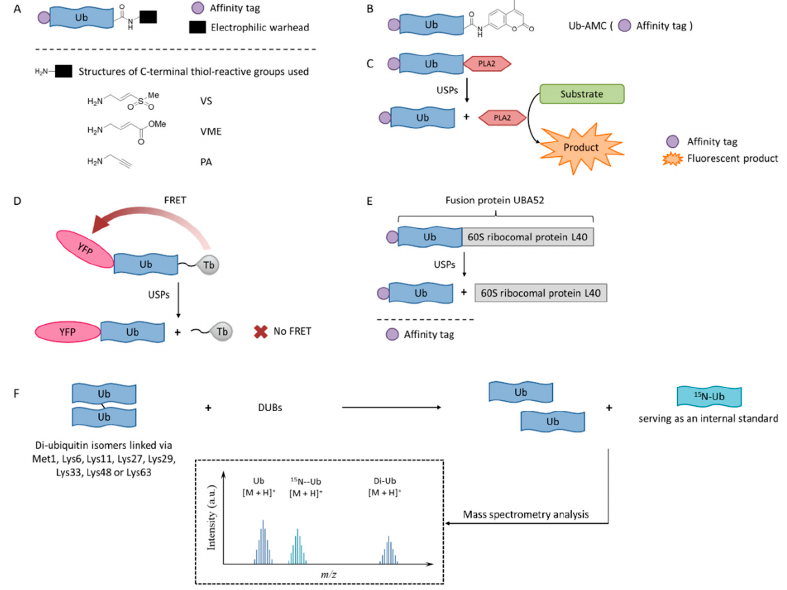
Figure 3. USPs inhibitor screening methods. ( A ) Activity-based probe (ABP) structures; ( B ) Ub-7- amino-4-methylcoumarin (AMC) structure; ( C ) Ub-phospholipase A2 (PLA2) assay; ( D ) Time-resolved fluorescence resonance energy transfer (TR-FRET) assay; ( E ) UBA52 structure and the SDS-PAGE-Coomassie assay; ( F ) Matrix-assisted laser desorption/ionization time-of-flight (MALDI-TOF) method.